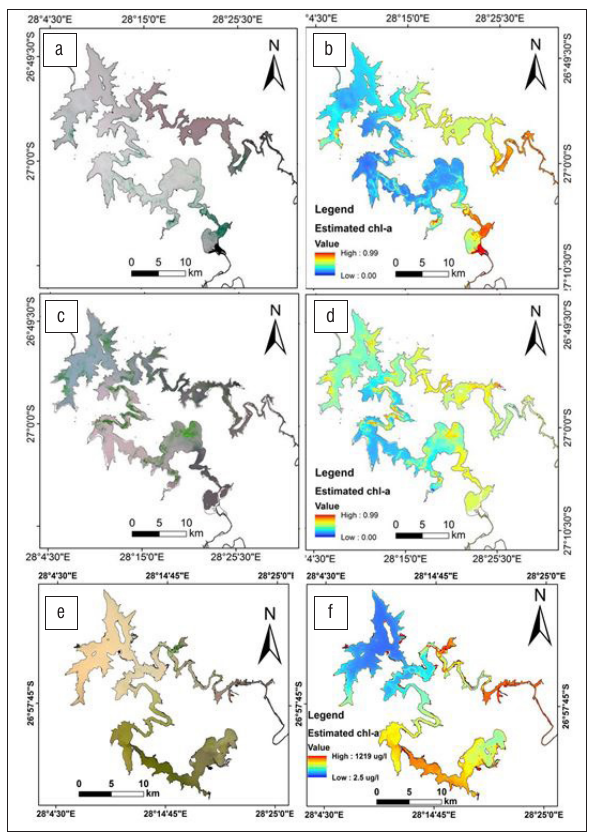
The stepwise logistic regression results depicting predicted distribution of chl- a within the Vaal Dam. The true colour maps are indicated by (a), (c) and (e) and their corresponding results in (b), (d) and (f).